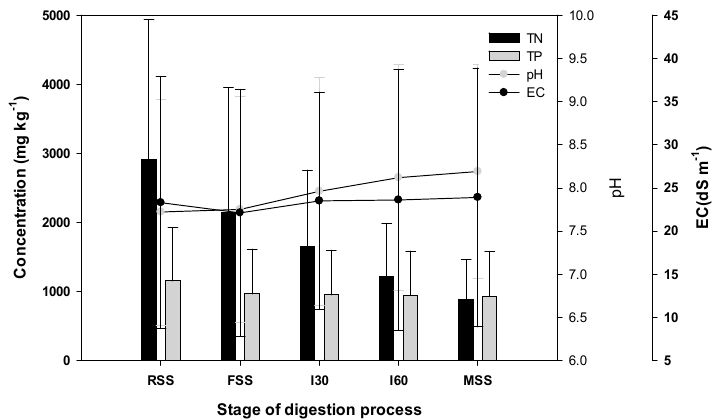
Figure 3. Changes of mean proportion of chemical properties from RSS to MSS.